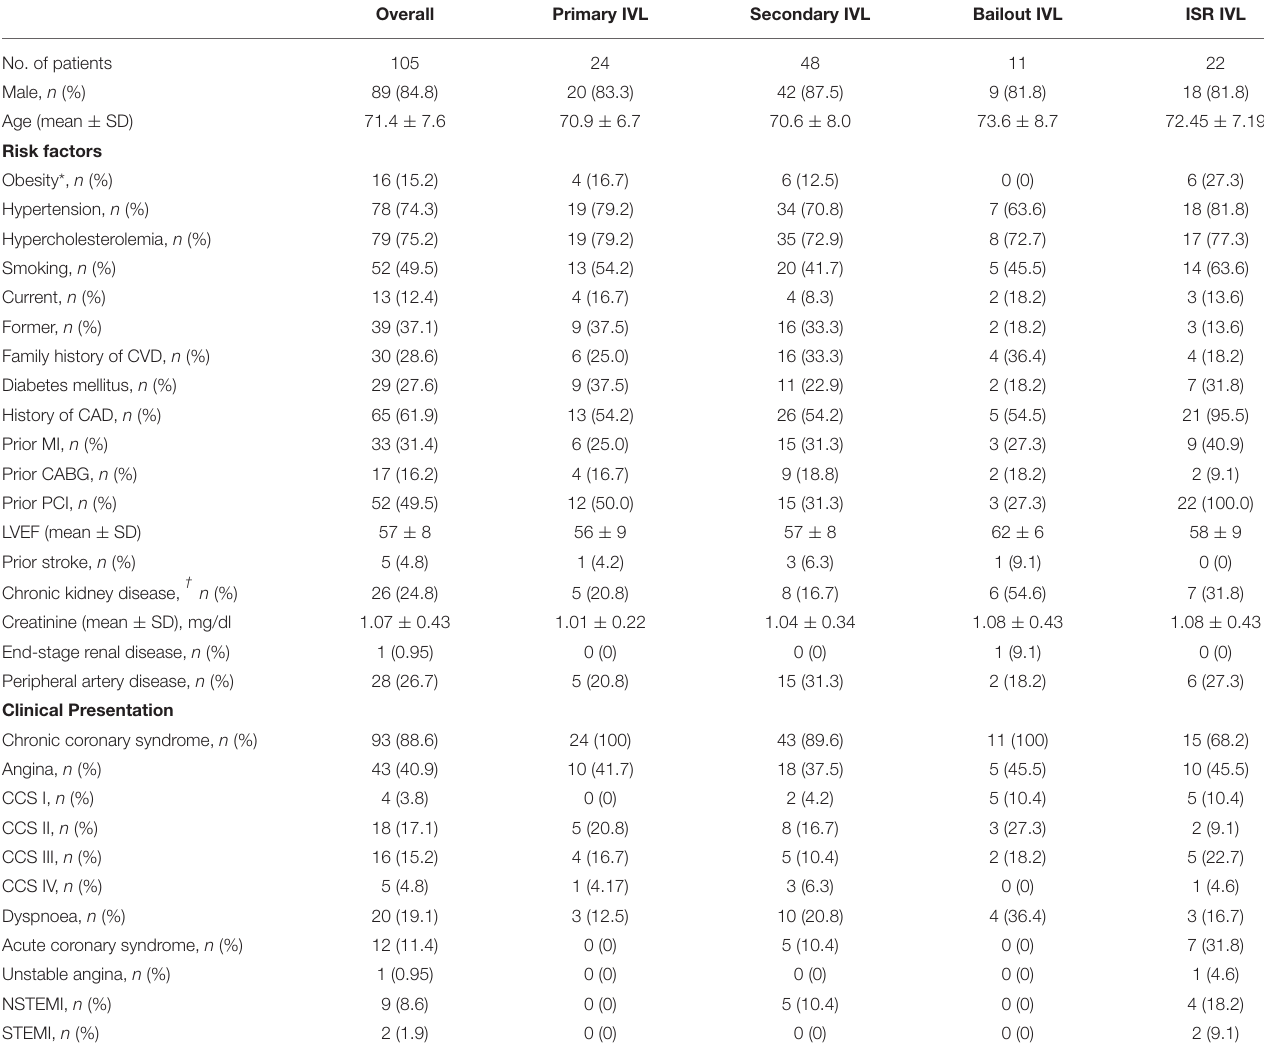
TABLE 1 | Baseline clinical characteristics of overall population and patient subgroups. Overall Primary IVL Secondary IVL Bailout IVL ISR